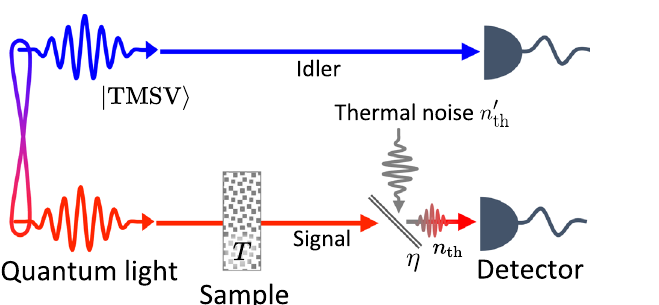
Figure 5. Schematic illustration of an alternative quantum setup, in which the noise is introduced to the signal